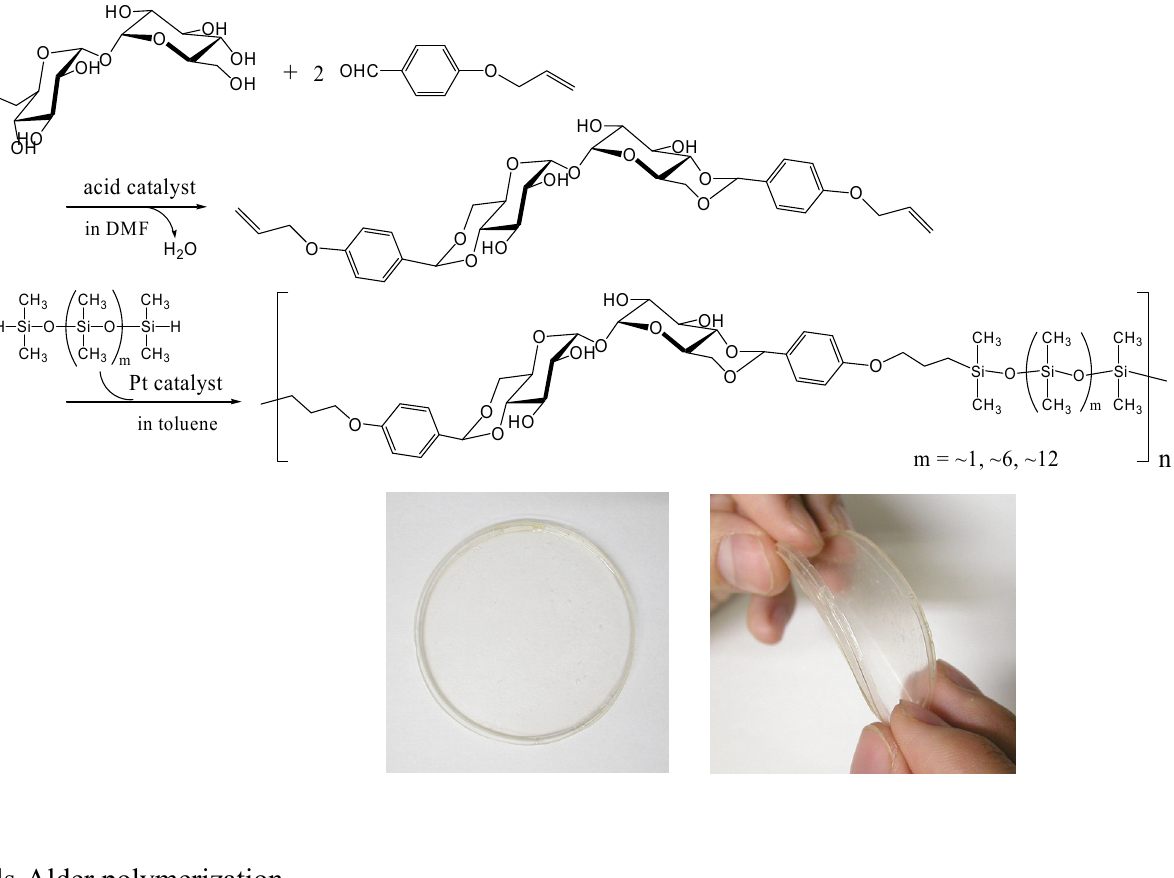
Figure 17. Synthesis of thermoplastic and flexible polymers containing trehalose and dimethylsiloxane oligomer units by hydrosilylation reaction (reproduced from the reference [253] with the permission of the Society of Polymer Science,